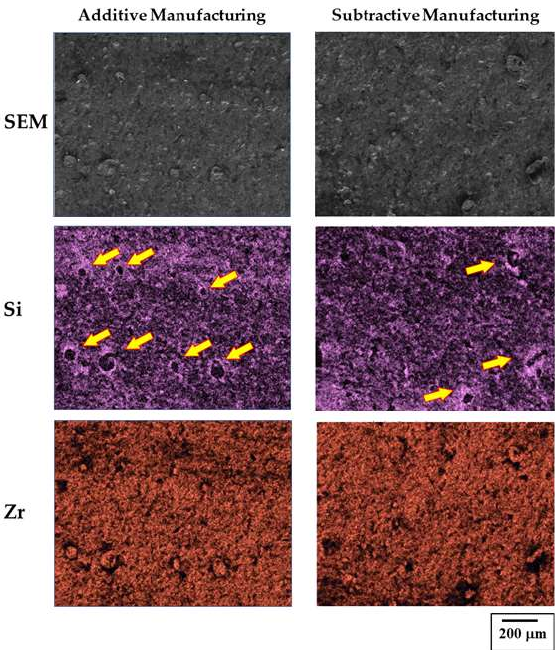
Figure 6. SEM and element (Si and Zr) mapping images of the zirconia specimens prepared via additive manufacturing and subtractive manufacturing. additive manufacturing and subtractive